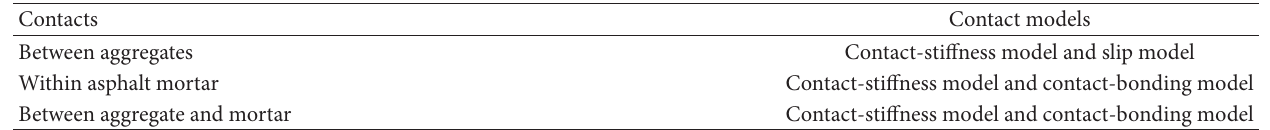
Table 2: Contact models at different contacts within asphalt concrete.